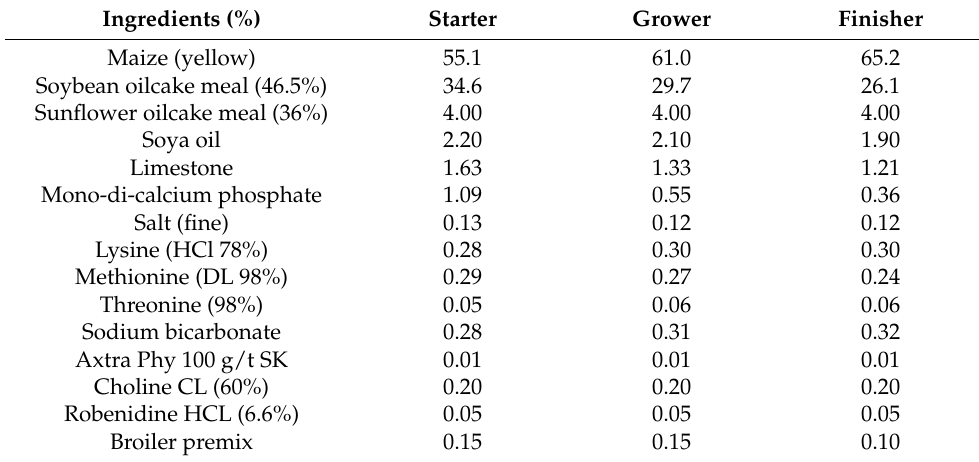
Table 11. Feed composition (%) of the basal